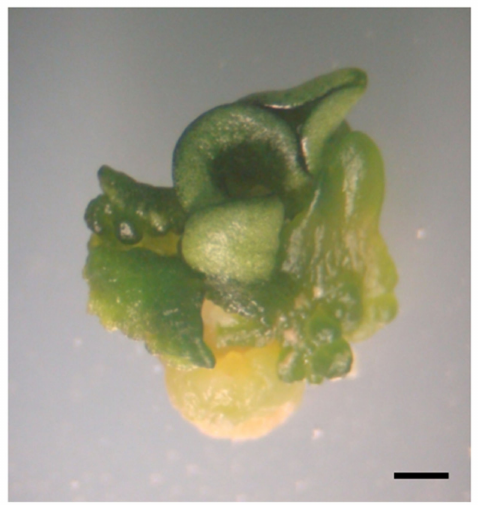
Figure 2. Somatic embryo germination on one-third strength MS medium containing 10 g L − 1 sucrose, showing cotyledon greening with no root development. The bar corresponds to 1